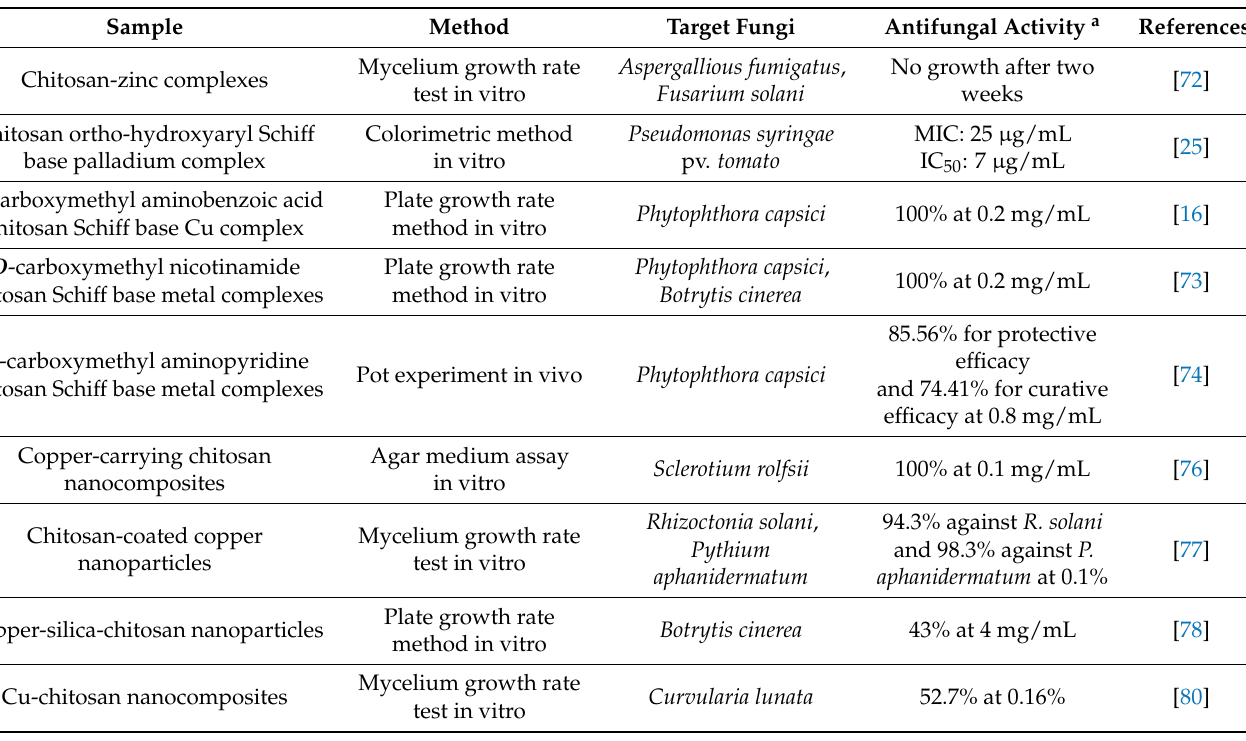
Table 5. Antifungal properties of some chitosan metal complexes and nanocomposites.